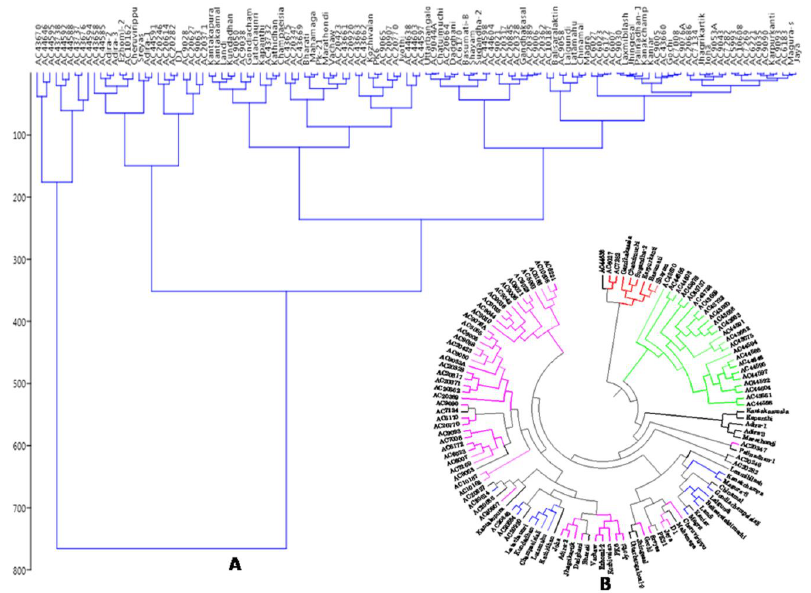
Figure 8. ( A ) Grouping of the panel germplasm lines A. Ward’s clustering based on the antioxidant content ( B ) Unrooted tree using unweighted-neighbor joining method depicting clustering pattern of 120 germplasm lines with respect to 136 molecular markers colored on the basis of subpopulations obtained from structure analysis (SP1: Pink; SP2; Blue; SP3: Red; SP4: Green, and Admix: